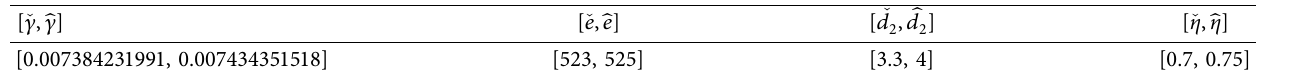
Table 2: Parameters set in subsection 4.1.